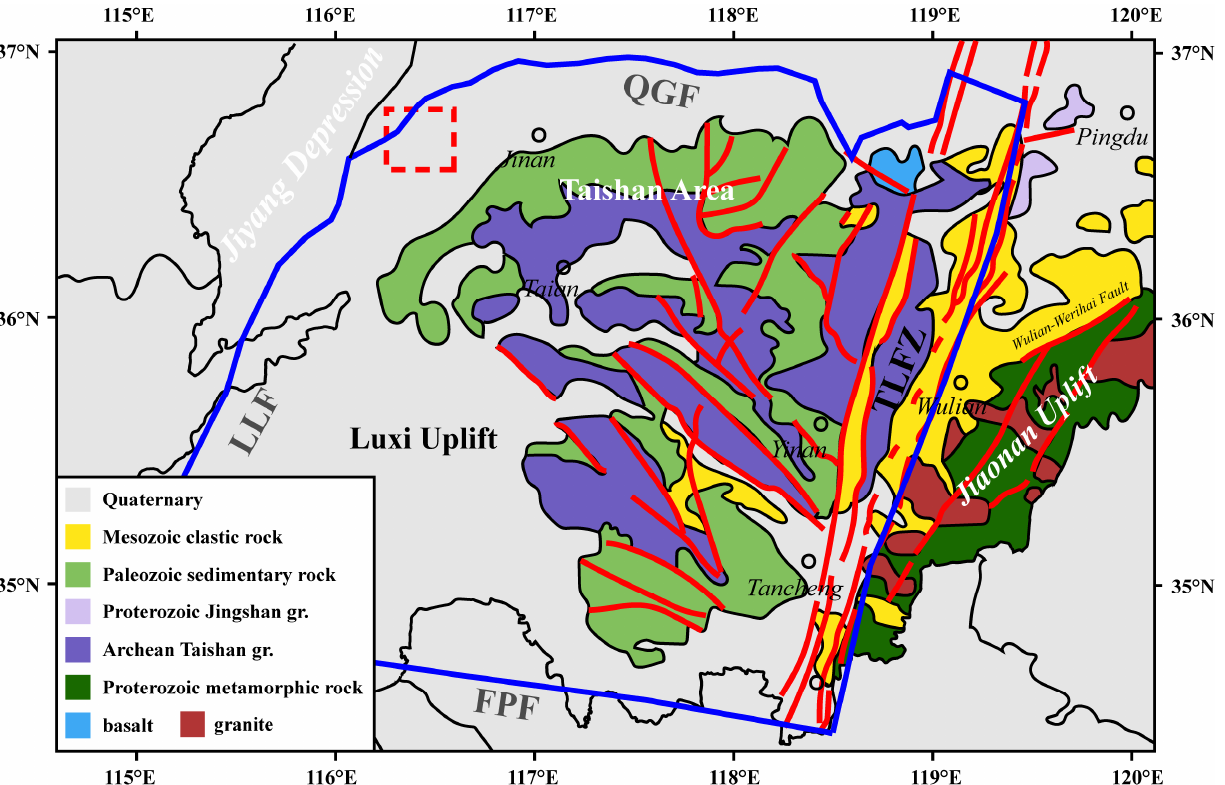
Figure 1. Regional geological structural map of Luxi Uplift, modified from [14]. Red dashed rectangle is the research area; red solid lines show known major faults; blue solid lines are boundary of Luxi Uplift. QGF: Qihe–Guangrao fault, LLF: Lankao–Liaocheng fault, FPF: Feng–Pei fault, TLFZ: Tan–Lu fault zone.